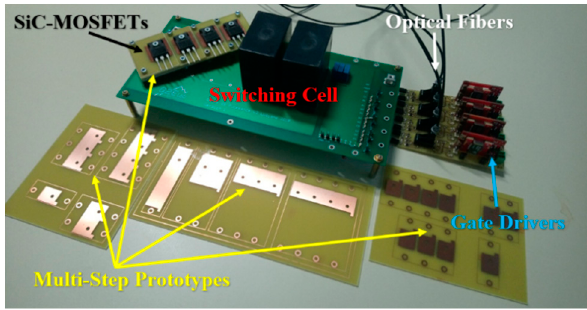
Figure 14. Switching cell and MSP prototypes.